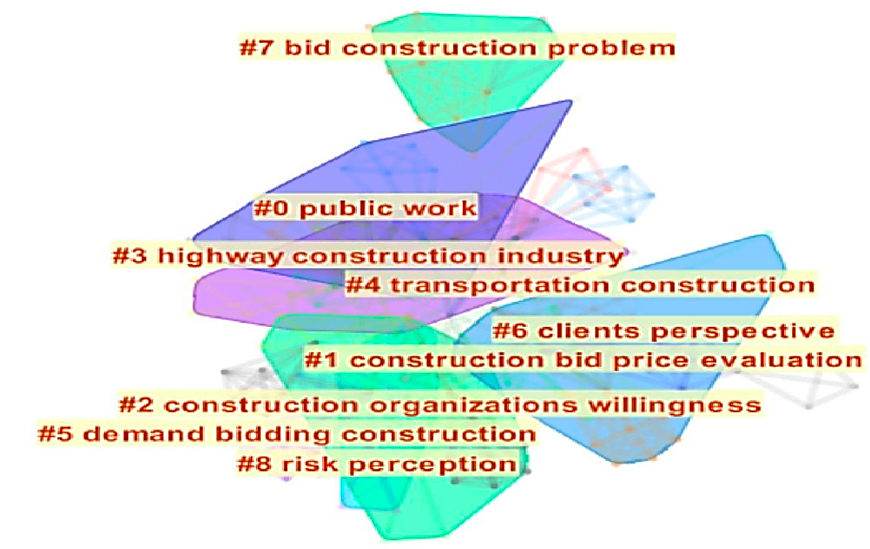
Figure 4. Cluster analysis of construction bidding. Table 3. List of clusters in construction bidding